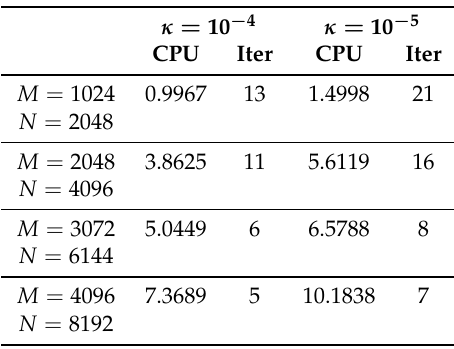
Table 6. The convergence behavior Algorithm 4 with different cases of M and N